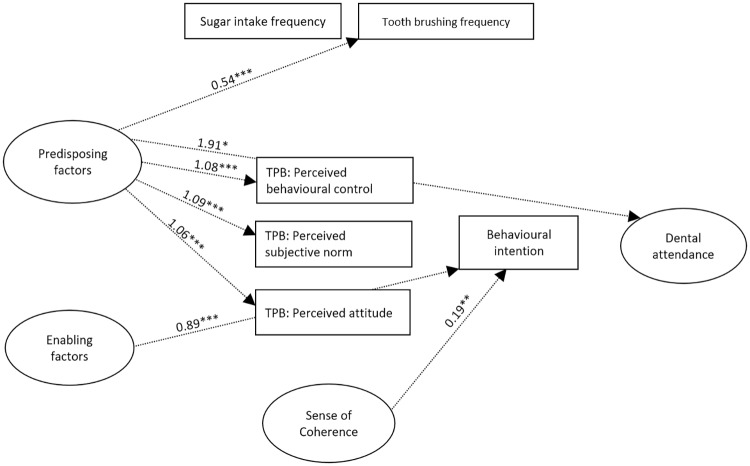
Bootstrapped standardized indirect effect estimates for the amended TPB for dental attendance in preschool children illustrated with dotted arrows.For ease of interpretation, only significant paths shown, and error and indicator variables omitted. * p < .05, ** p < .01, *** p ≤ .001.